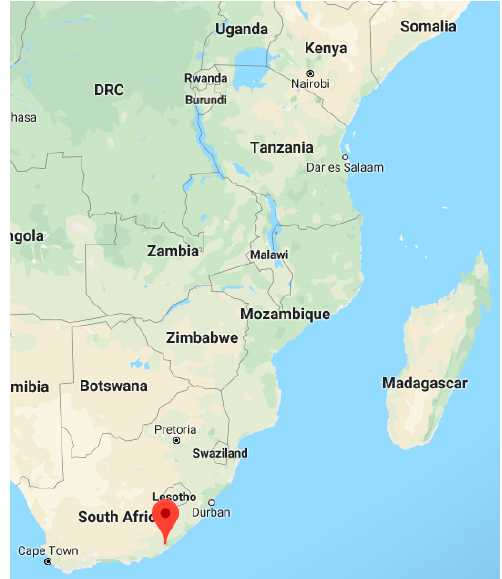
Figure 2. East London in South Africa, map from Google Maps (www.google.com/maps (accessed on 21 August 2018)).